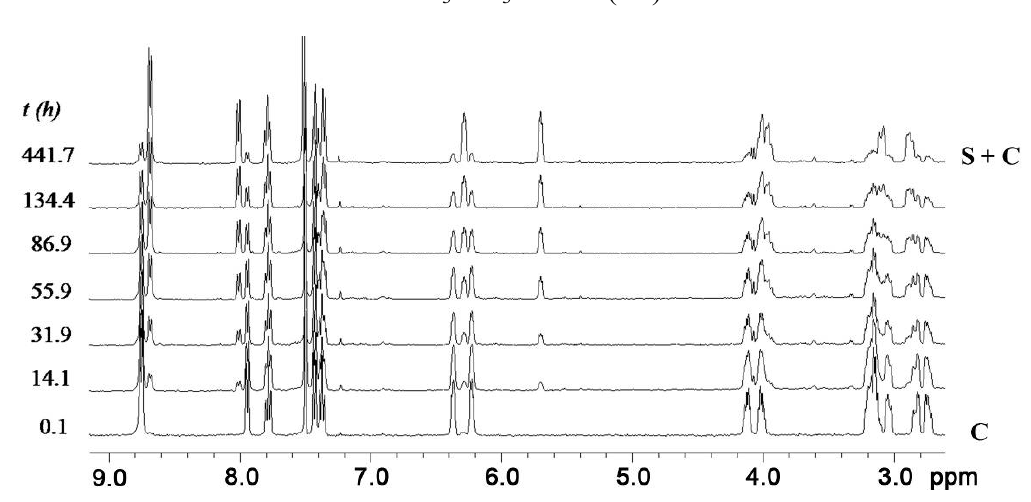
Figure 2. Series of partial 400 MHz 1 H-NMR spectra in time revealing the decrease in abundance of cis -linked isomer C in favor of the thermodynamically more stable